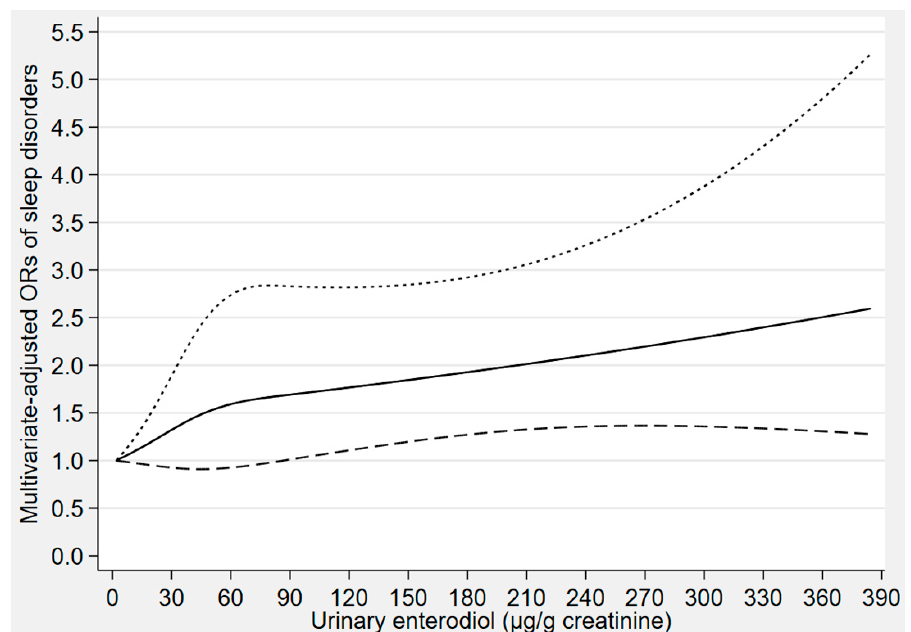
disorders. The solid line represents the estimated odds ratios (ORs) and the dashed lines represent their 95% confidence intervals. The relationship was adjusted for gender, age, marital status, race, occupation, family income, educational level, body mass index, smoking status, alcohol consumption, use of female hormones, physical activity, caffeine intake, C-reactive protein, hypertension, depressive symptoms, diabetes, and the other five phytoestrogens (tertiles).